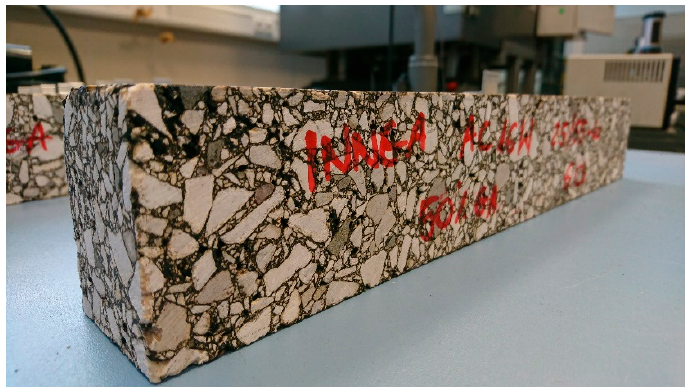
Figure 2. Beam for four-point bending beam test (4PB) fatigue and stiffness test.